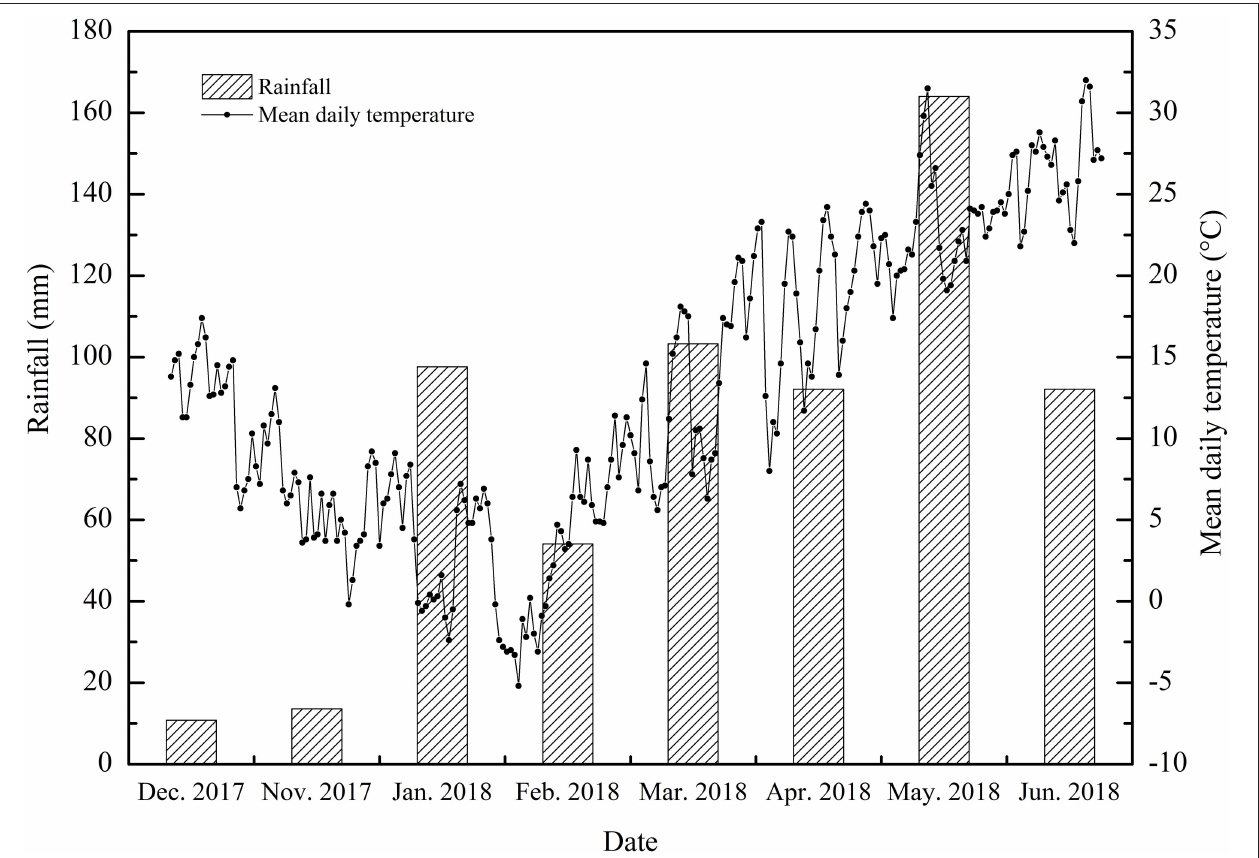
FIGURE 1 | The average daily temperatures and monthly rainfall during the wheat-growing seasons (2017–2018).